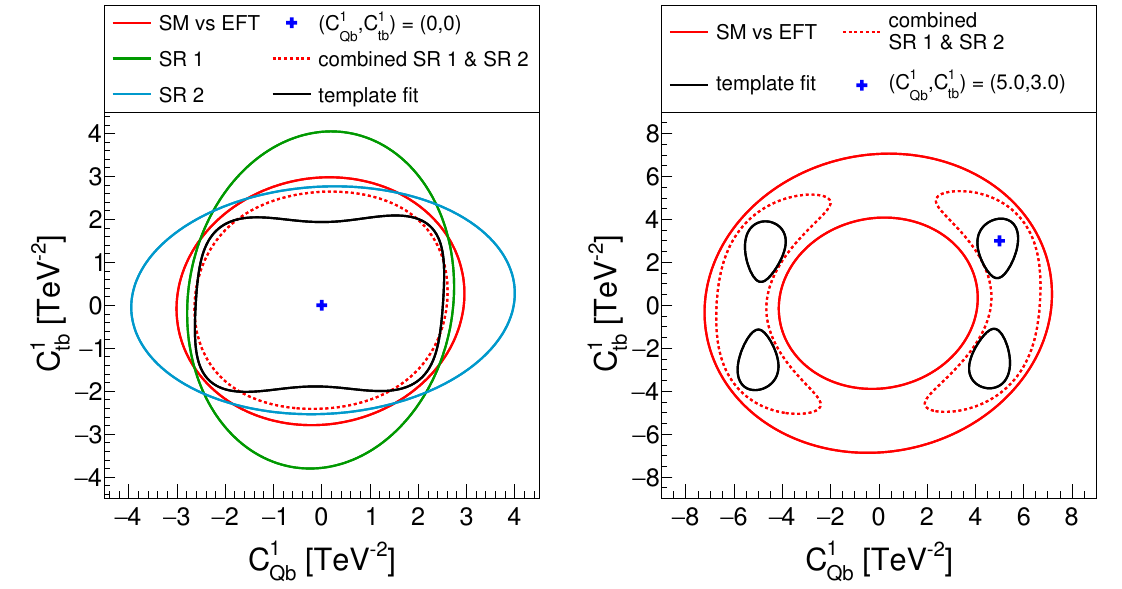
Figure 14 . (Left) Two-dimensional limits at 95% CL assuming a measurement consistent with the SM-only hypothesis (blue cross) and allowing two couplings, C 1 (red) one dimensional cut on P ( t L ) + P ( t R ) output; (green) SR1; (blue) SR2; (red dashed) combi- nation of SR1 and SR2; (black) two dimensional template (cid:12)t. (Right) Same as on the left plot, but for the EFT signal injection hypothesis. See text and (cid:12)gure 13 for more